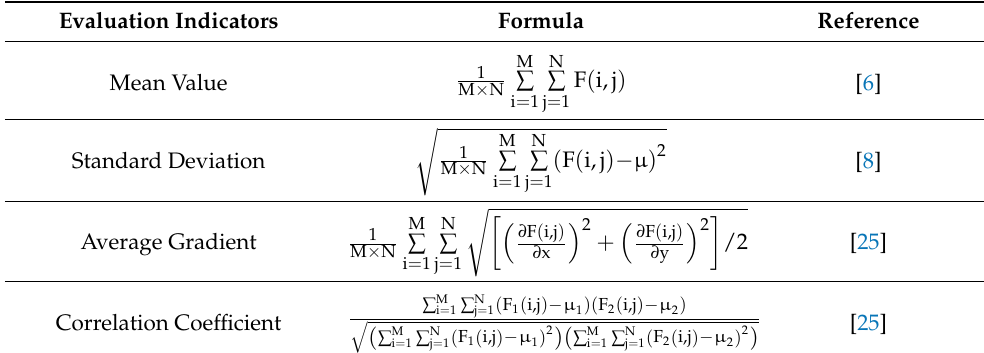
Table 1. Fused image quality evaluation indicators. Evaluation